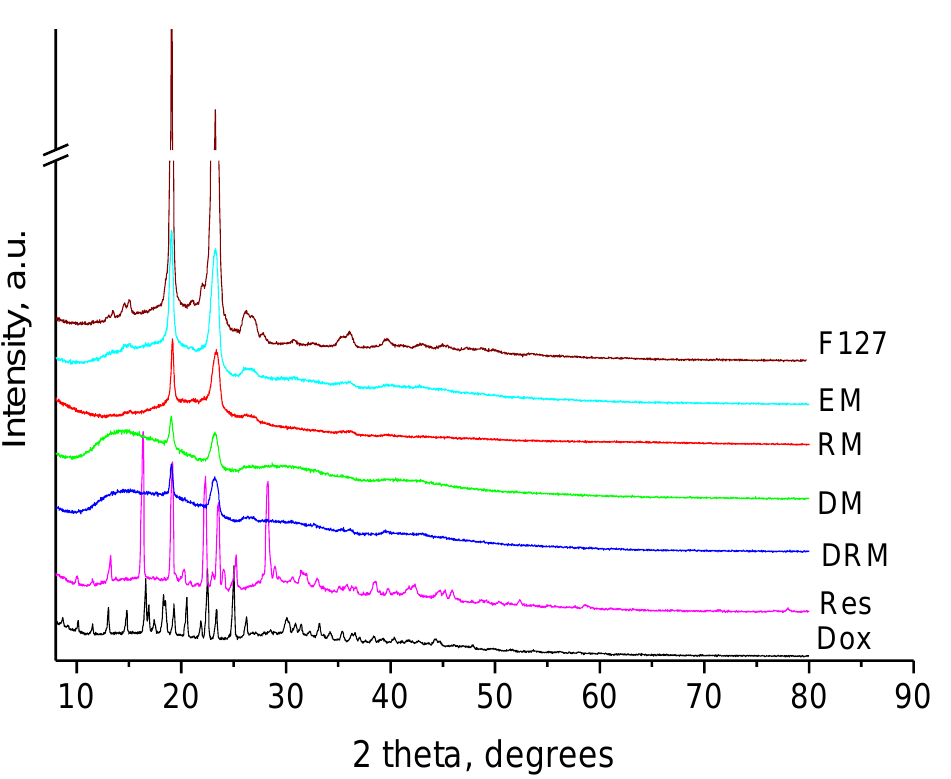
Figure 6. Powder XRD patterns of Pluronic F127 (F127), empty micelles (EM), resveratrol (Res), doxorubicin (Dox), single resveratrol-loaded micelles (RM), single doxorubicin-loaded micelles (DM) and the double-loaded micelles (DRM).